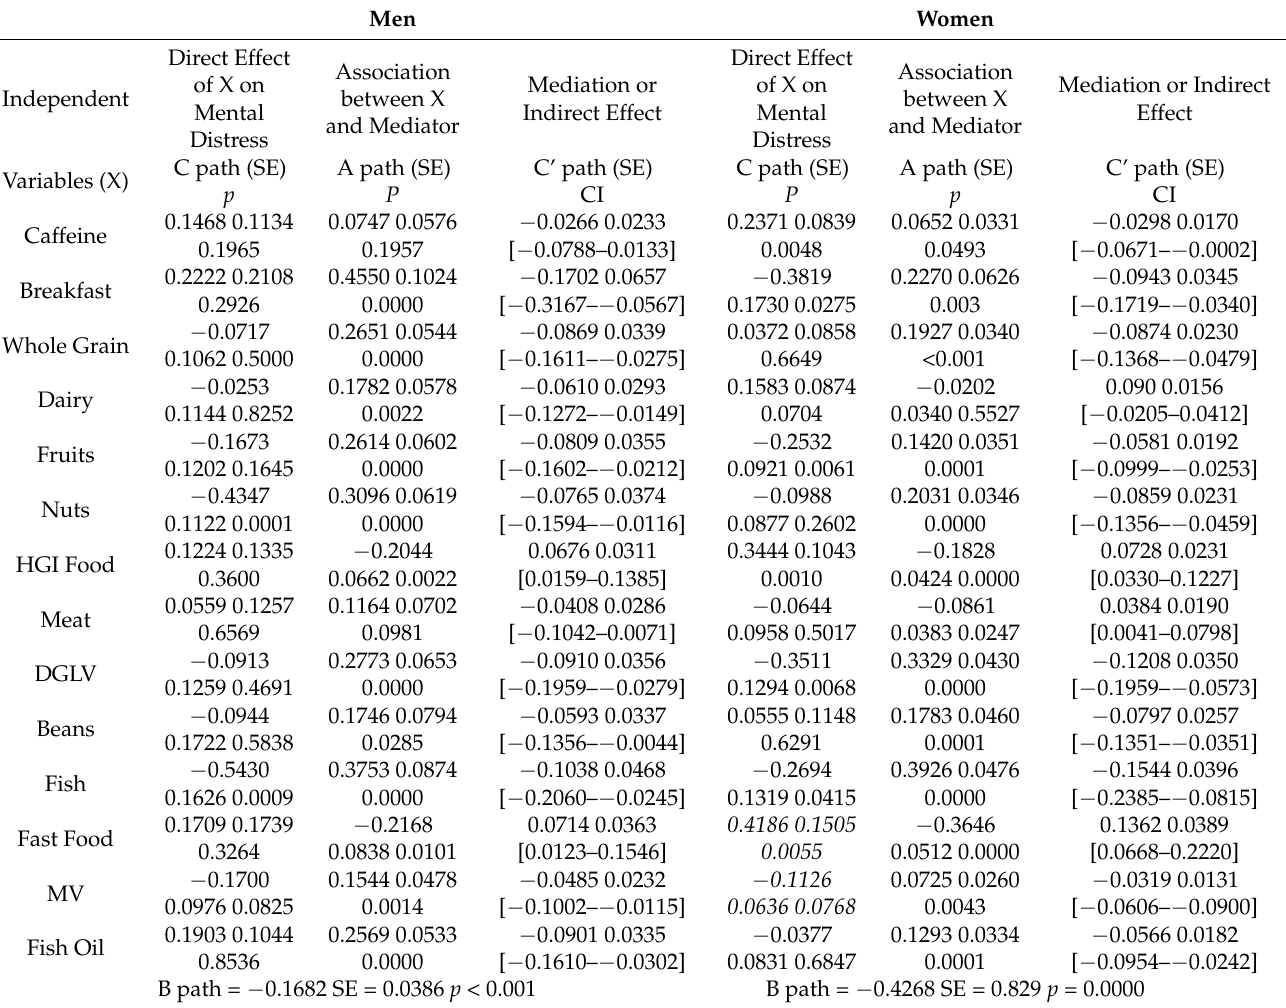
Table 2. Mediation regression analysis results for mature men and